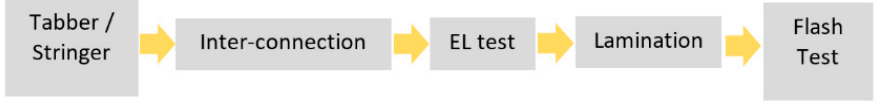
Figure 11. Descriptive sketch PV module production.